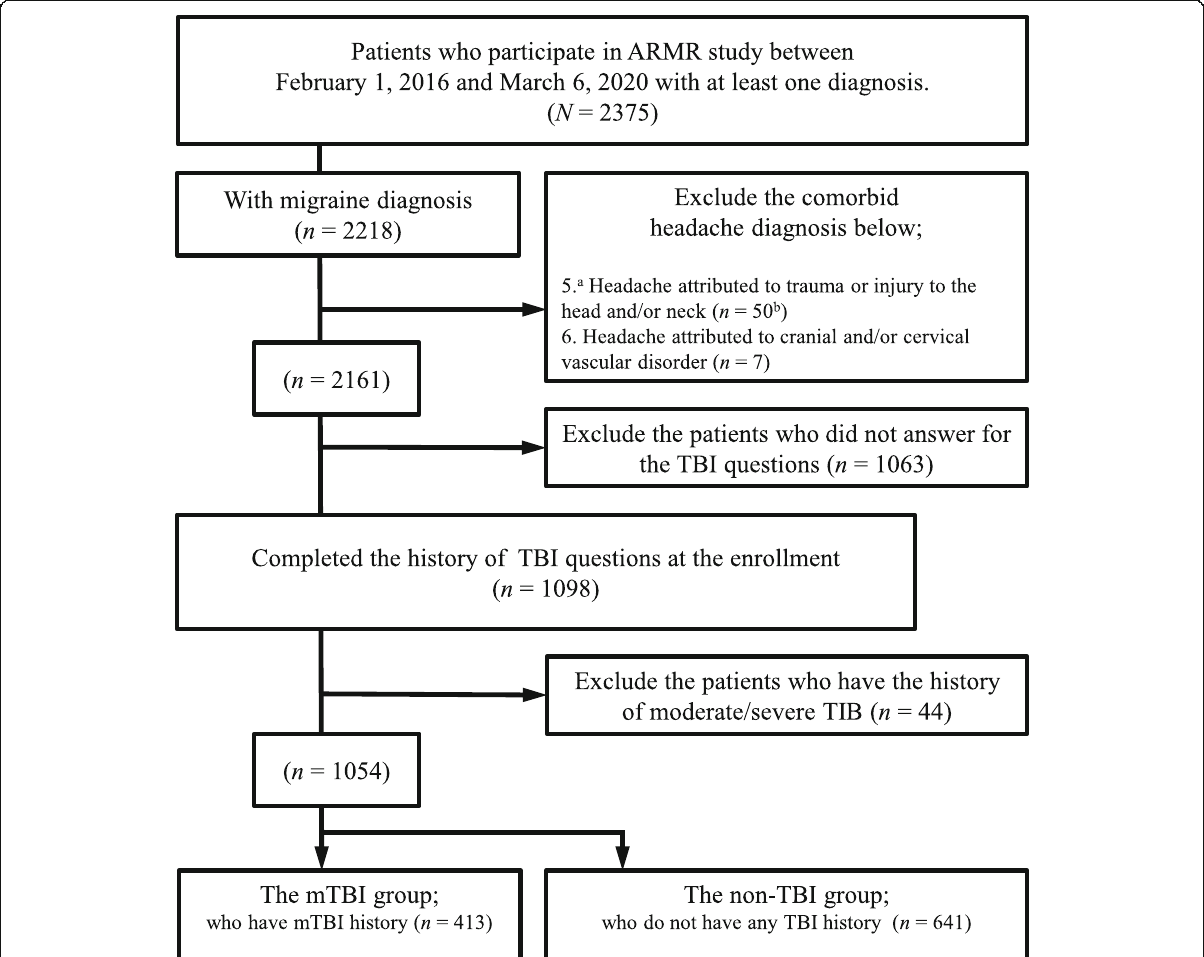
Fig. 1 Flow-chart summarizing inclusion and exclusion of patients a The first numbers indicate the ICHD-3 diagnosis code. b The last numbers indicate the number of patients excluded because of having that headache or facial pain type. ARMR: American Registry for Migraine Research, TBI: traumatic brain injury, mTBI: mild traumatic brain